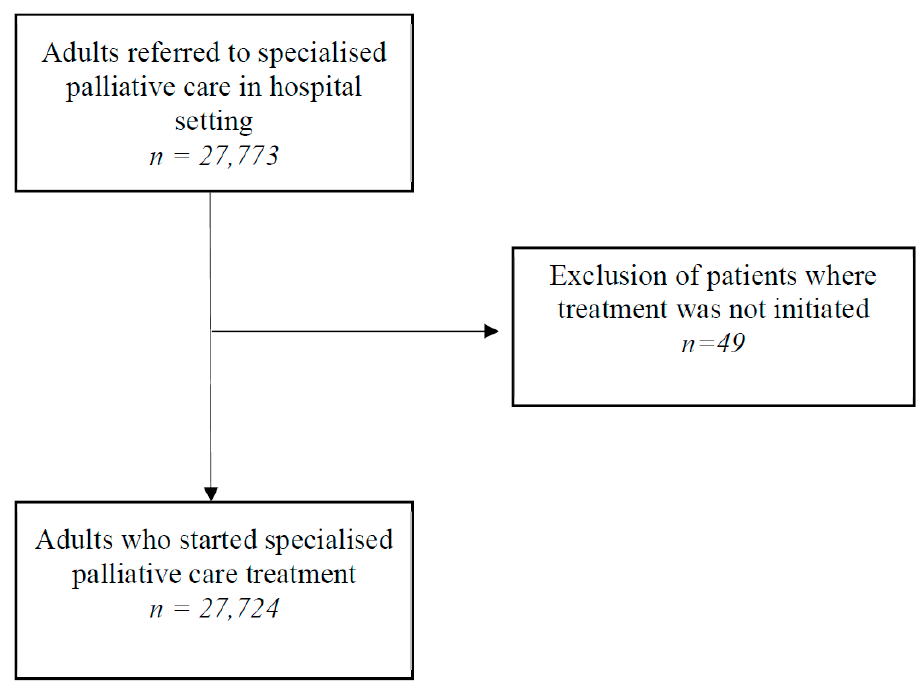
Figure 1. Diagram of patient selection.